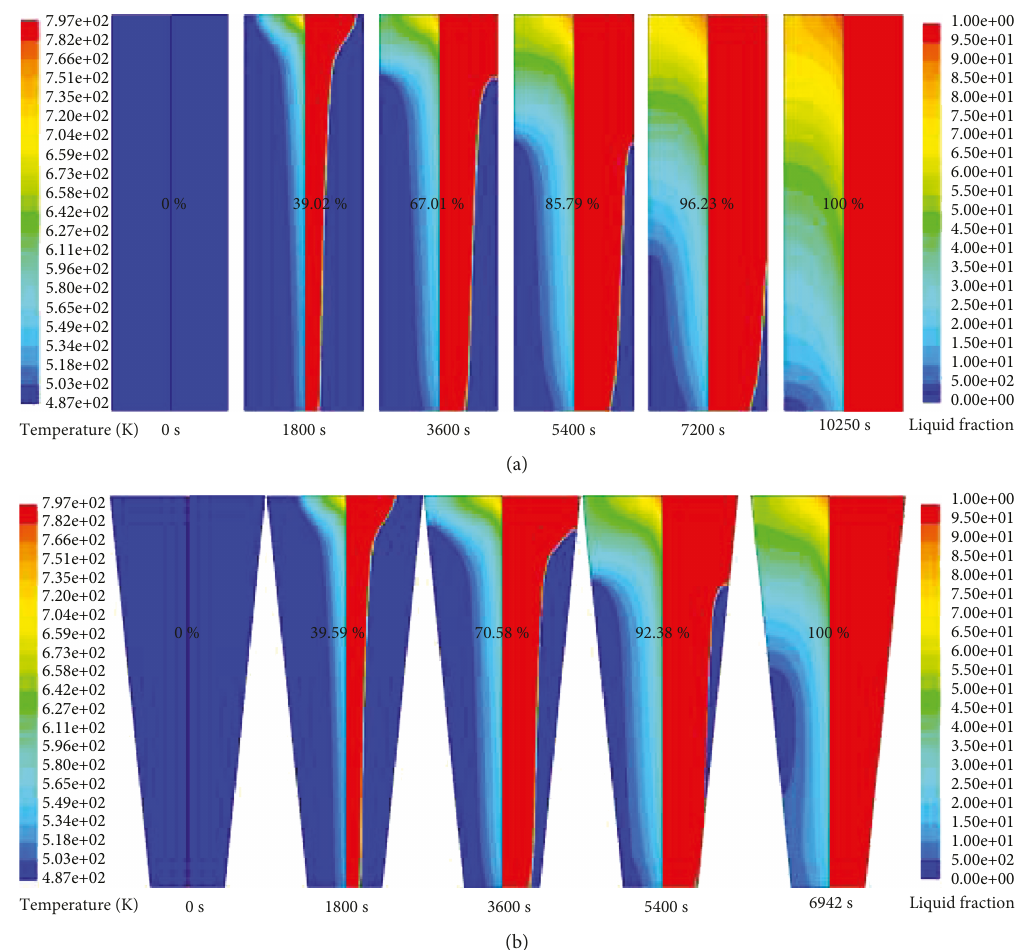
Figure 3: Contour of the PCM temperature (left) and liquid fraction (right) in the (a) cylindrical and (b) truncated cone model during the charging